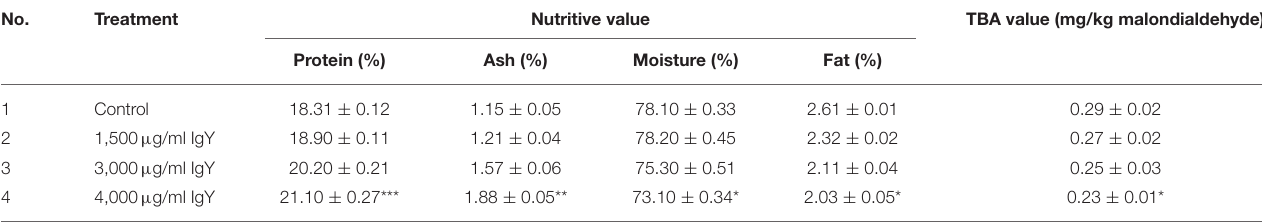
TABLE 8 | Impact of the different immunoglobulin Y (IgY) concentrations in the broilers’ diet on meat quality.